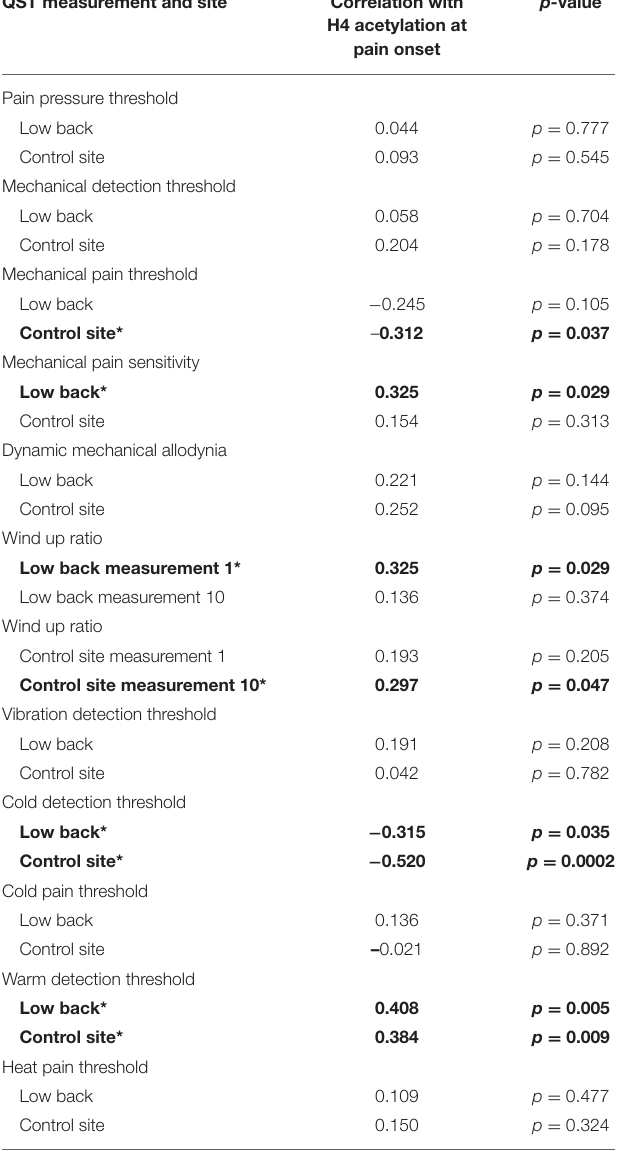
TABLE 5 | Correlation of quantitative sensory testing (QST) measures and H4 acetylation at the site of pain and the control site. QST measurement and site Correlation with